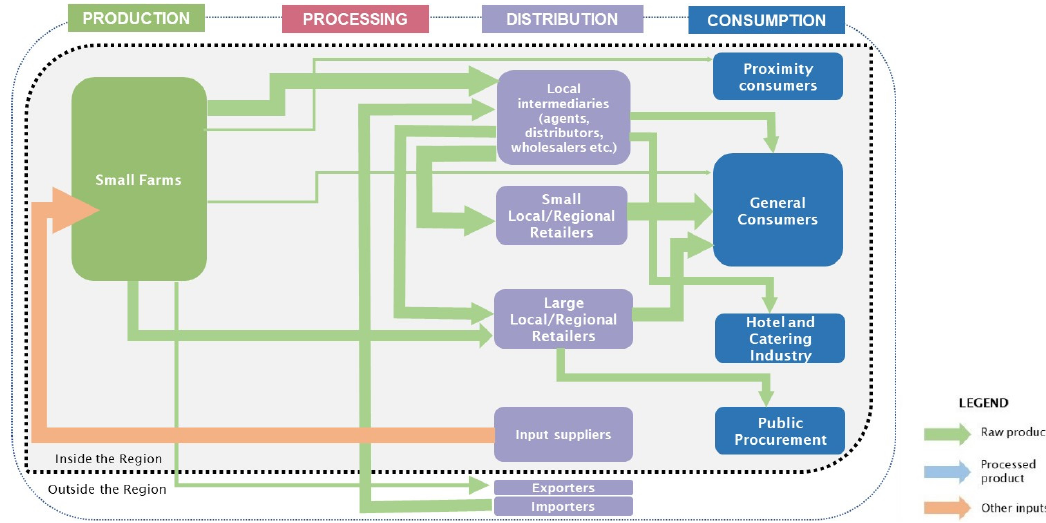
Figure 4. Regional food system for tomato.